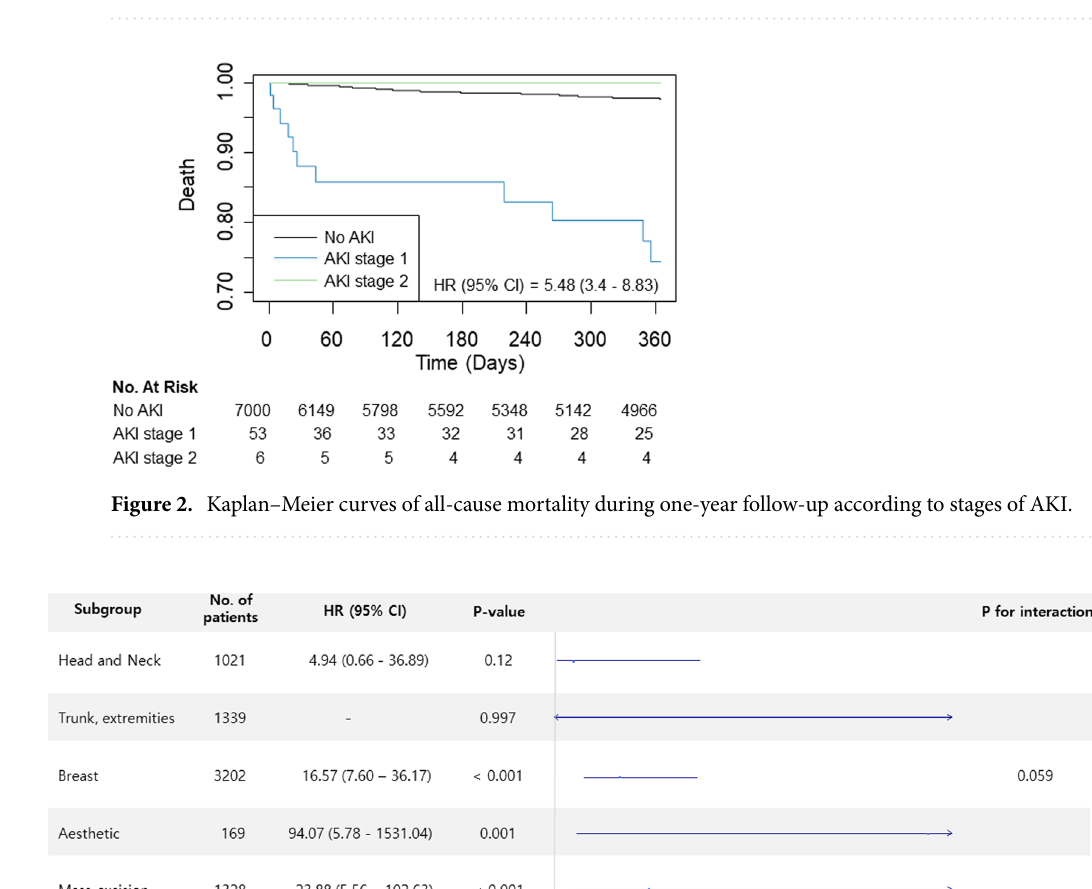
Figure 1. Kaplan–Meier curves of all-cause mortality during ( A ) one-year and ( B ) 30-day follow-ups.